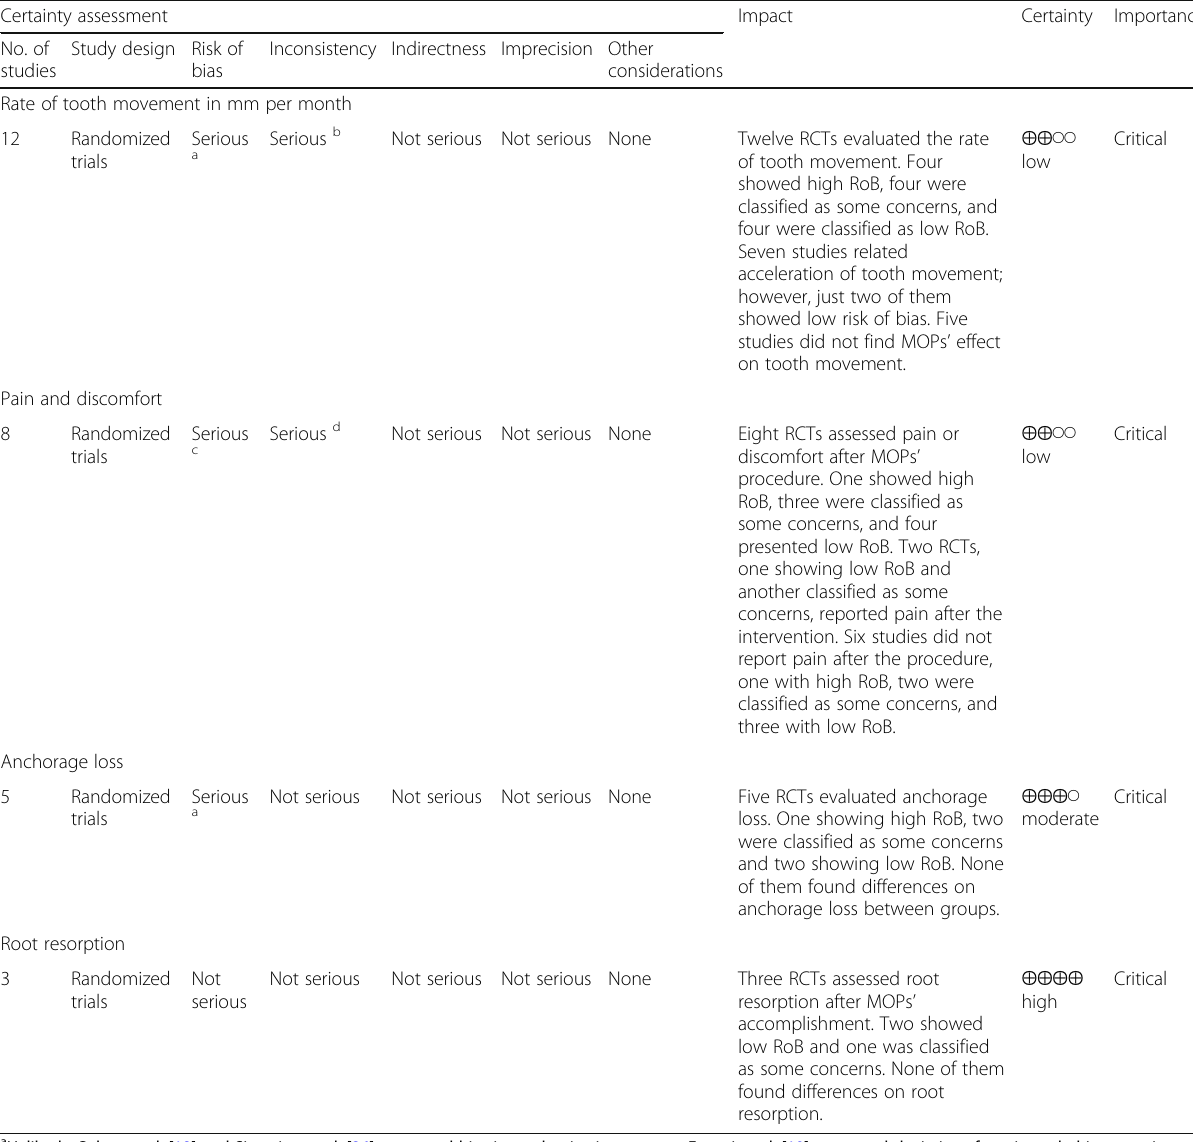
Table 3 Evaluation of the level of evidence by GRADE PRO assessment tool Certainty